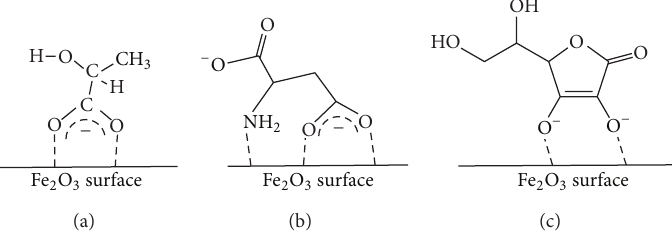
Figure 15: From left to right: lactate, aspartate, and ascorbate ions adsorbing on the iron oxide surface.